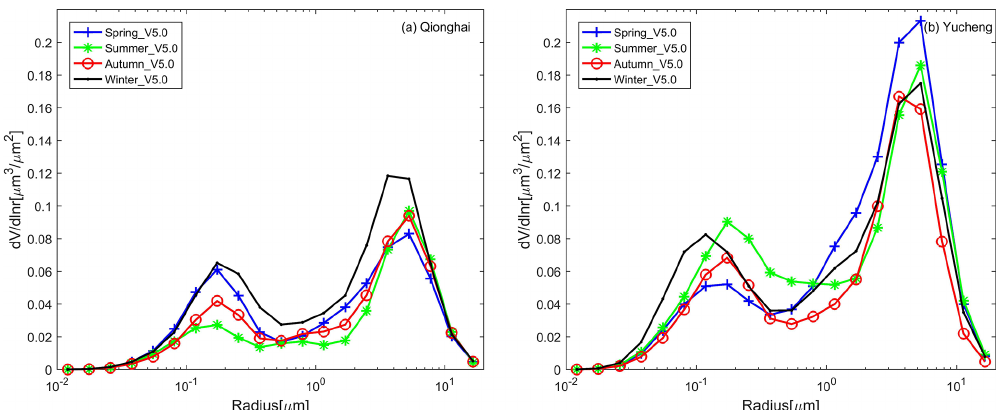
Figure 12. Seasonally averaged volumes of the different aerosol particle size distributions based on SKYRAD V5.0 over Qionghai (a) and Yucheng (b) for the period from February 2013 to December 2015.